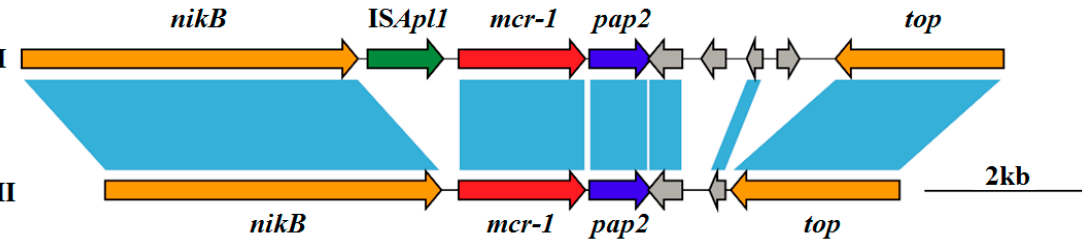
Figure 2. Schematic representation of sequences flanking mcr-1 gene. Genes and their corresponding transcriptional orientations are indicated by horizontal broad arrows. ( I ) One copy of IS Apl1 was present beside mcr-1 ; ( II ) no IS Apl1 was present beside mcr-1 .